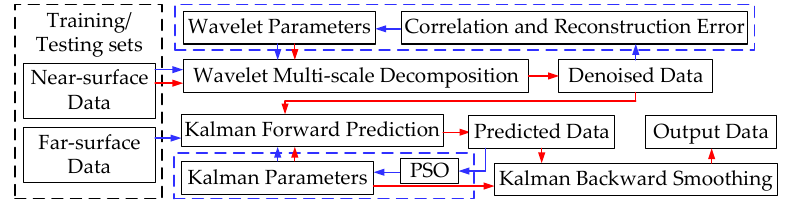
Figure 2. Wavelet-based Kalman smoothing (WBKS) algorithm flowchart. The blue dotted line and arrows represent the training process; the red arrows represent the testing process.